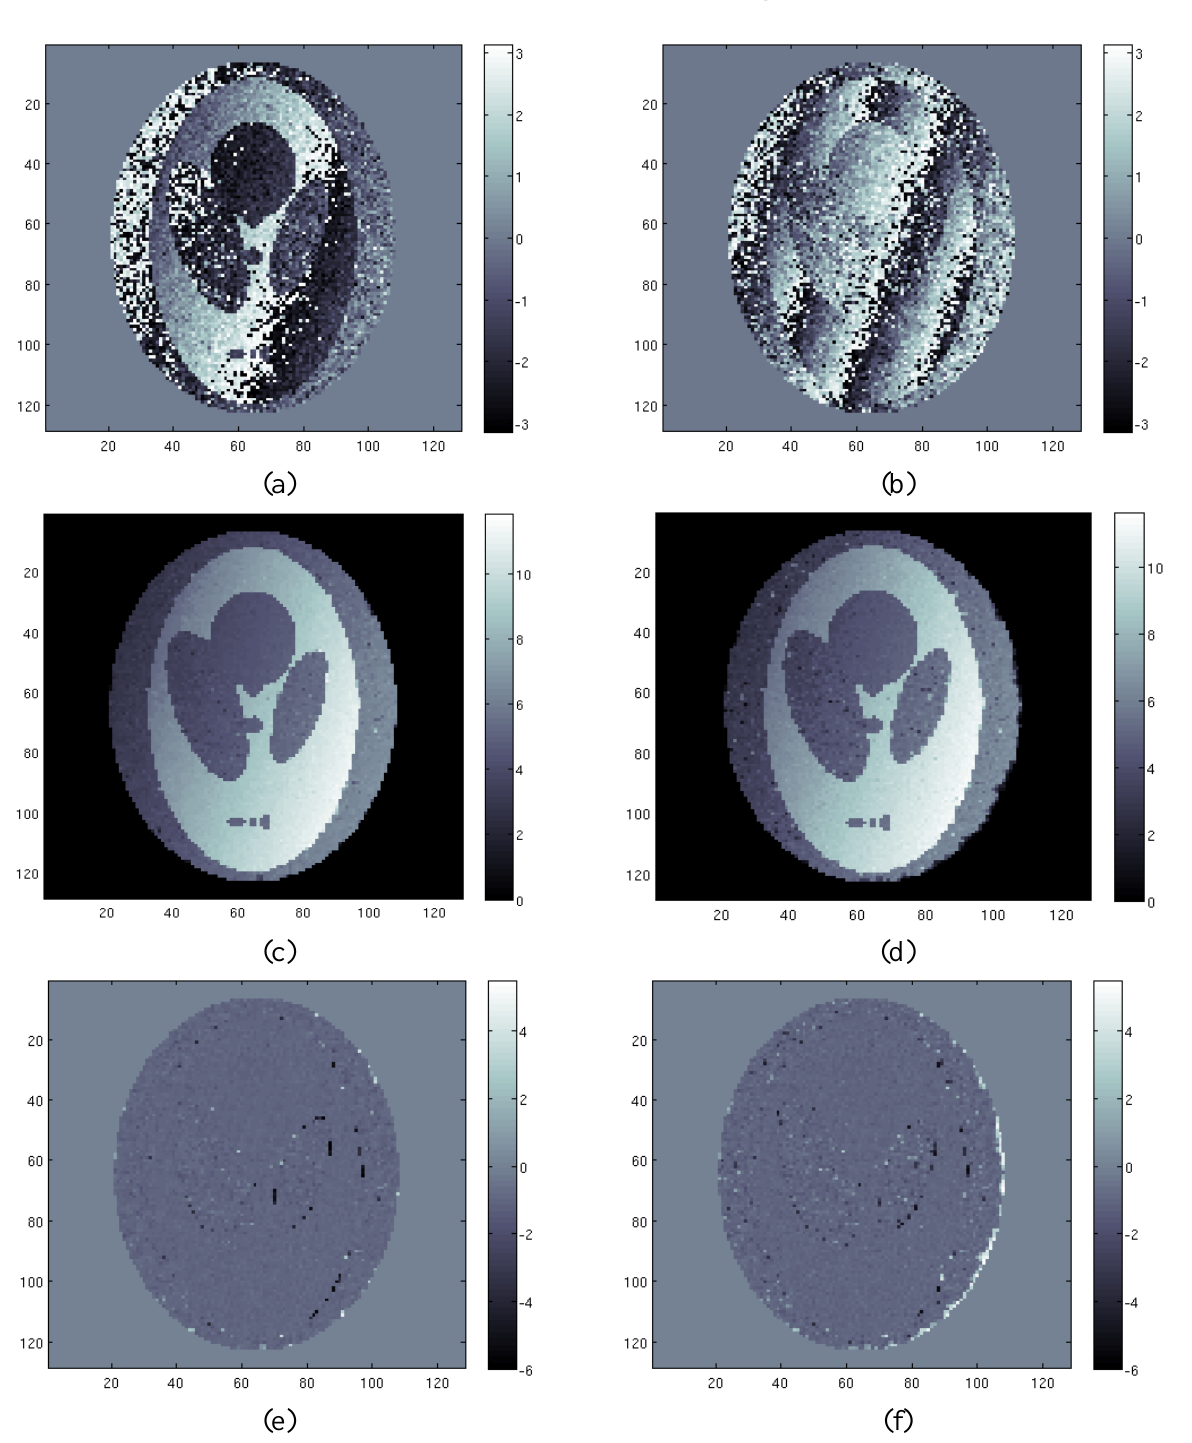
Figure 4. Second case study: (a) first phase image, (b) fourth phase image, (c) estimated field map using proposed method, (d) estimated field map using the approach of paper [4], (e) difference between estimated and the true field map using proposed method, (f) difference between estimated and the true field map using the approach of paper